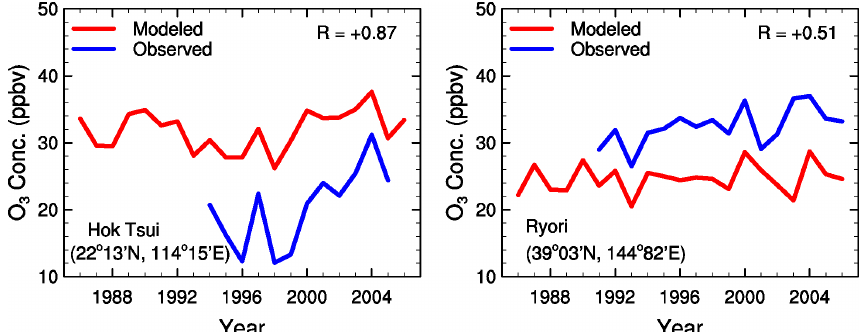
Figure 2. Comparisons of observed and simulated JJA mean surface-layer O 3 concentrations at Hok Tsui (22 ◦ 13 0 N, 114 ◦ 15 0 E) in Hong Kong (left) and Ryori (39 ◦ 03 0 N, 144 ◦ 82 0 E) in Japan (right). Correlation coefficient between simulations and observations is shown in the top-right corner of each panel, which is calculated over the time period with observations available.